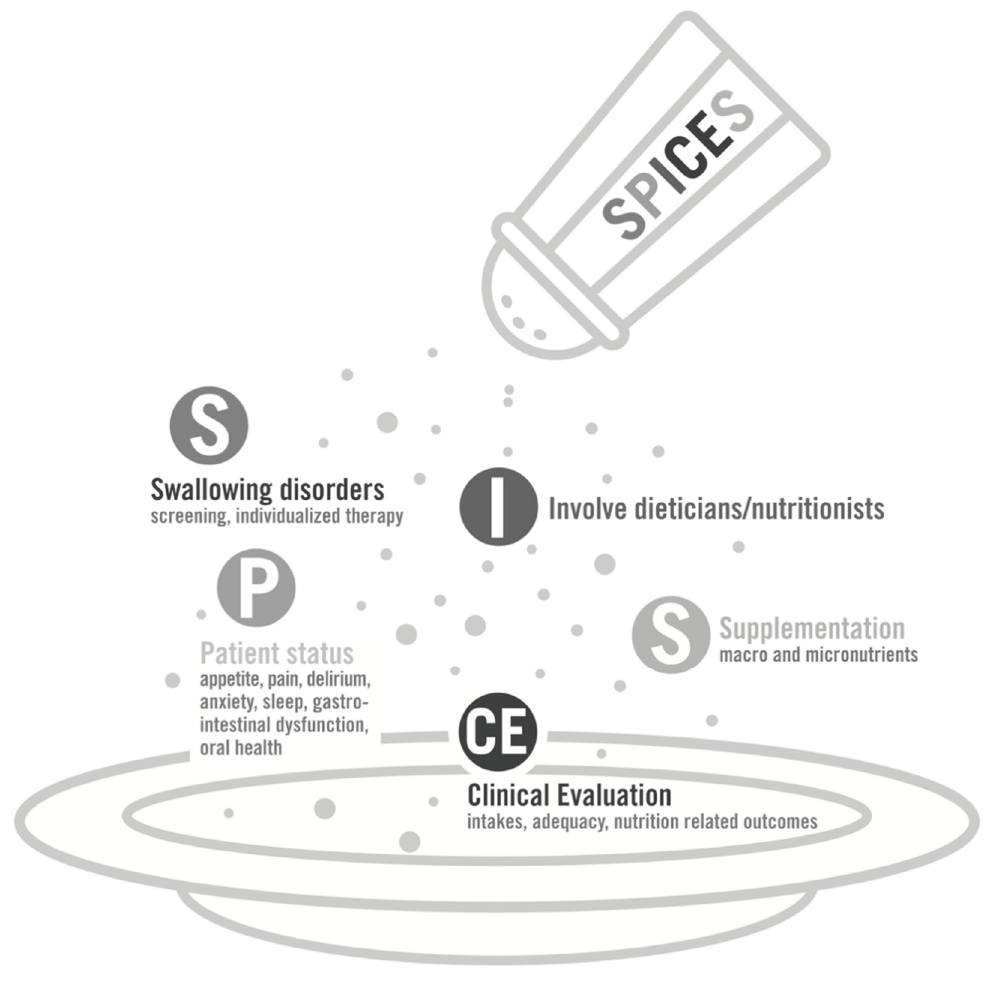
Figure 1. SPICES concept, detailing the different points to be addressed in a critically ill patient or an intensive care unit (ICU) survivor, aiming to optimize oral feeding.